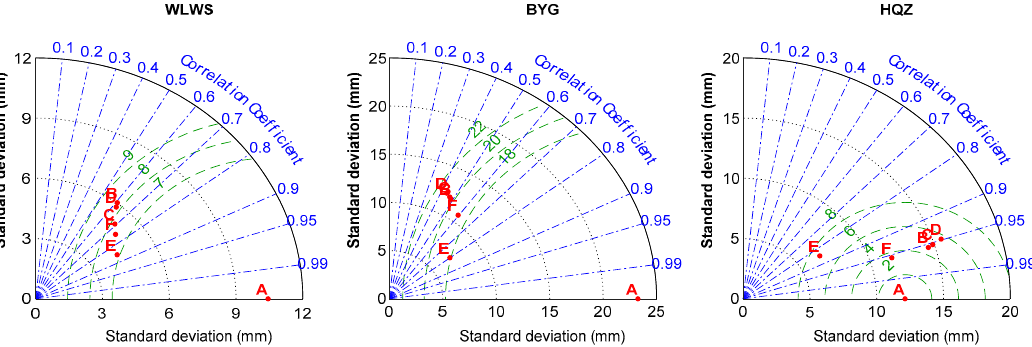
Figure 11. Taylor diagrams showing statistical comparisons between the observations and simulated SWE at 3-hour intervals between 0:00 on 1 November 2014 and 21:00 on 31 March 2015 using different surface aerodynamic roughness (z os ) values at the three sites.